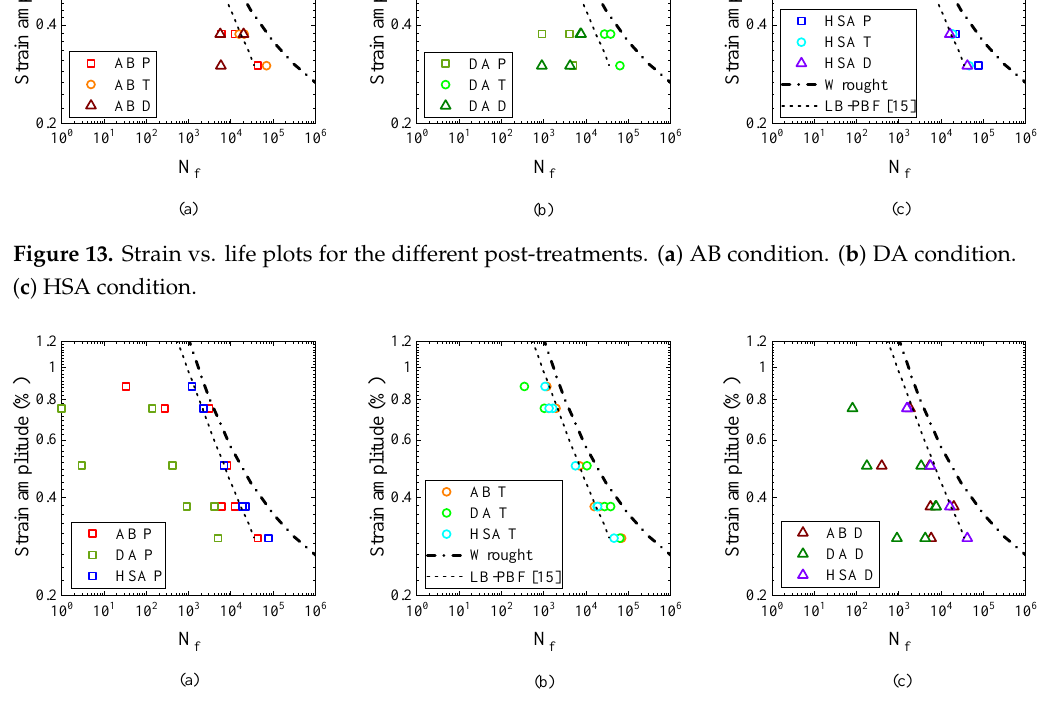
Figure 14. Strain vs. life plots for the different orientations. ( a ) Parallel orientation. ( b ) Transverse orientation. ( c ) Diagonal